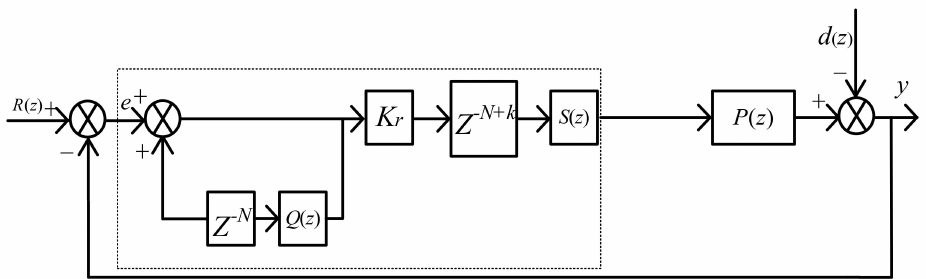
Figure 5. Block diagram of repetitive control